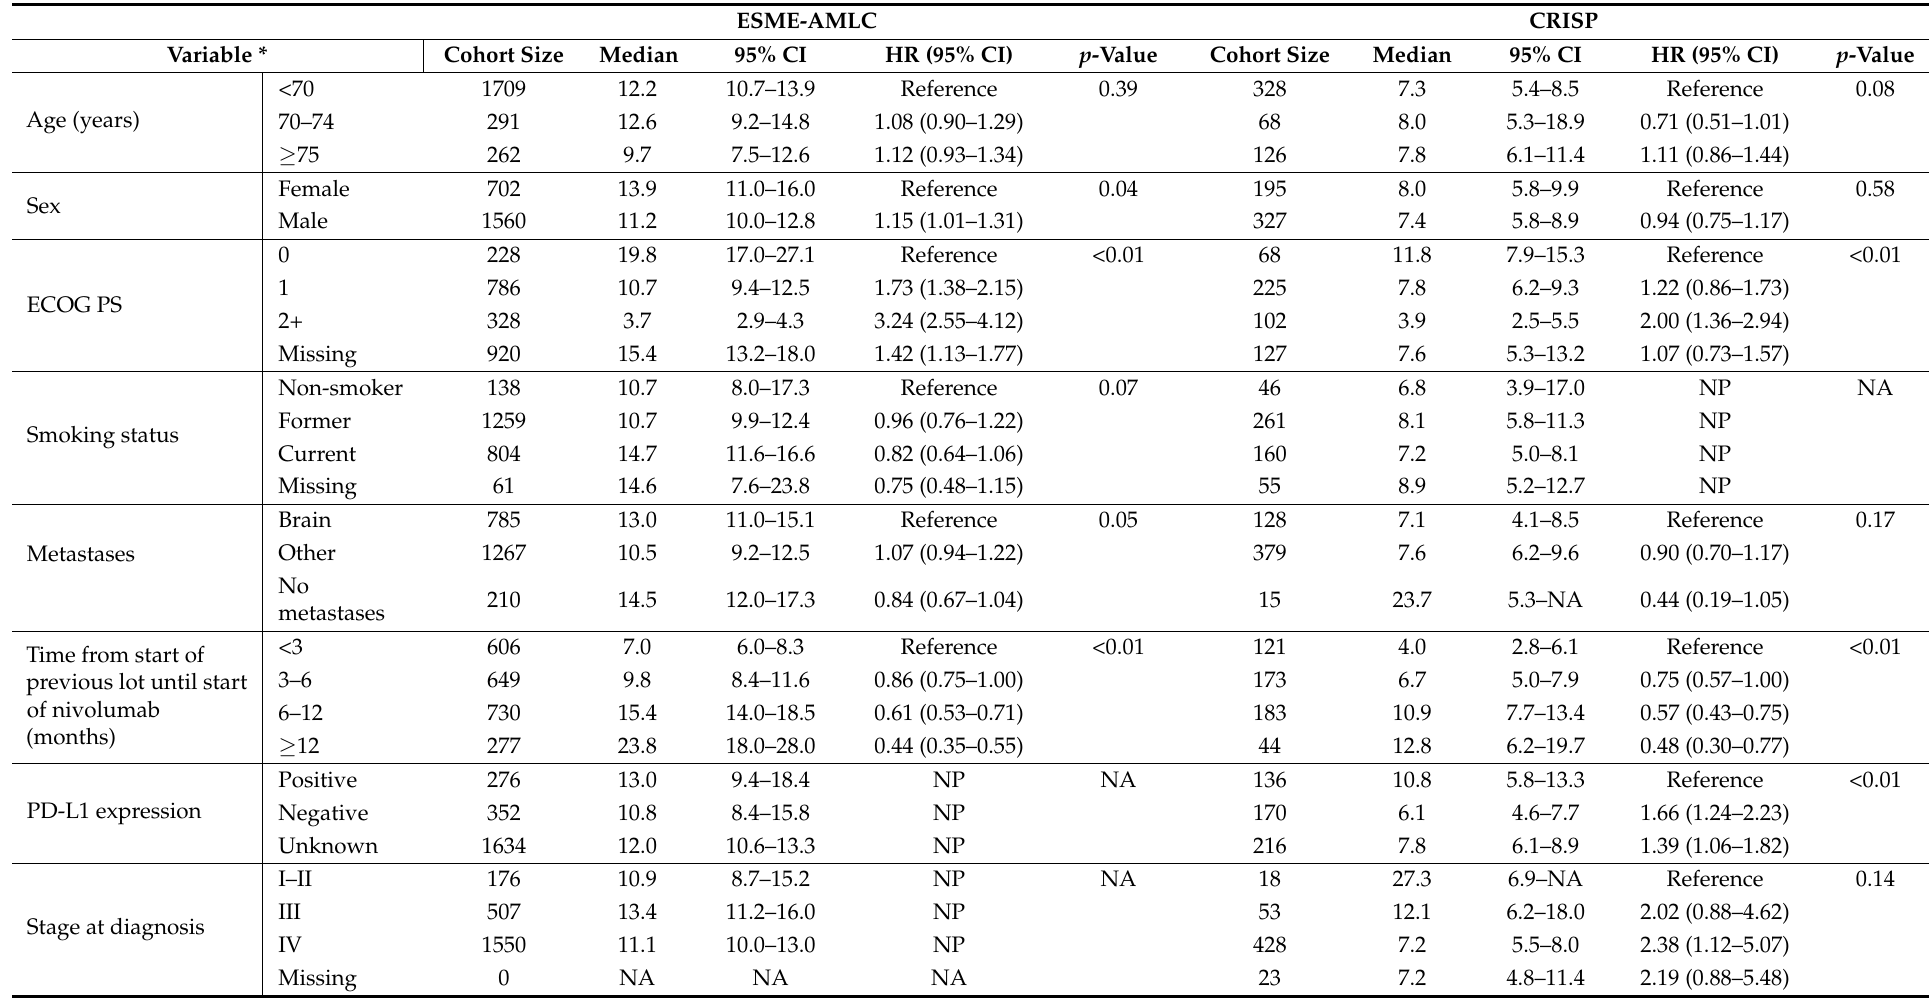
Table 5. Factors associated with overall survival in patients treated with nivolumab in ESME-AMLC and CRISP (multivariate Cox model; table and forest plot). ESME-AMLC